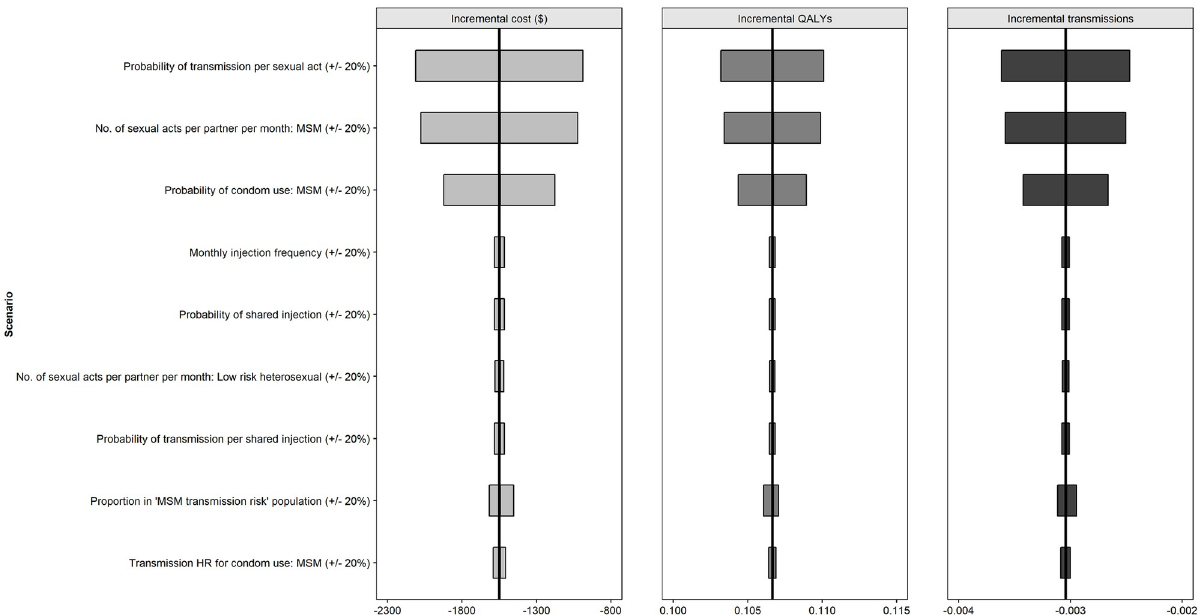
Fig 4. Deterministic (one-way) sensitivity analysis (CAB+RPV LA vs oral cART) viral transmission parameters. Abbreviations: HR: hazard ratio; MSM: men who have sex with men; QALY: quality adjusted life